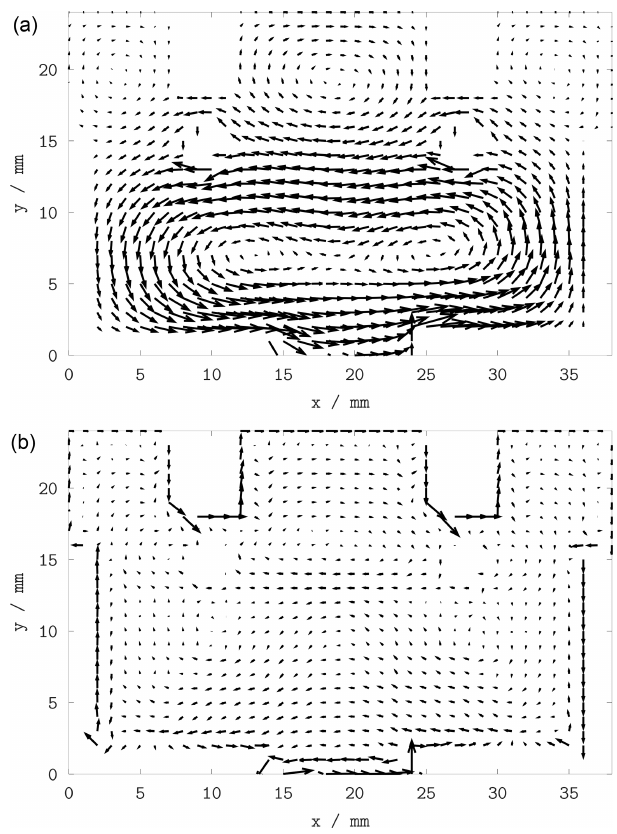
Figure 2. Eddy currents in the mounting body at the signal fre- quency 10Hz (a) and 100kHz (b) .